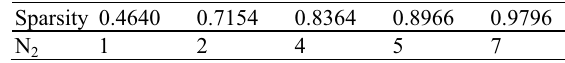
N and sparsity of the rating matrix. Table 11. 2